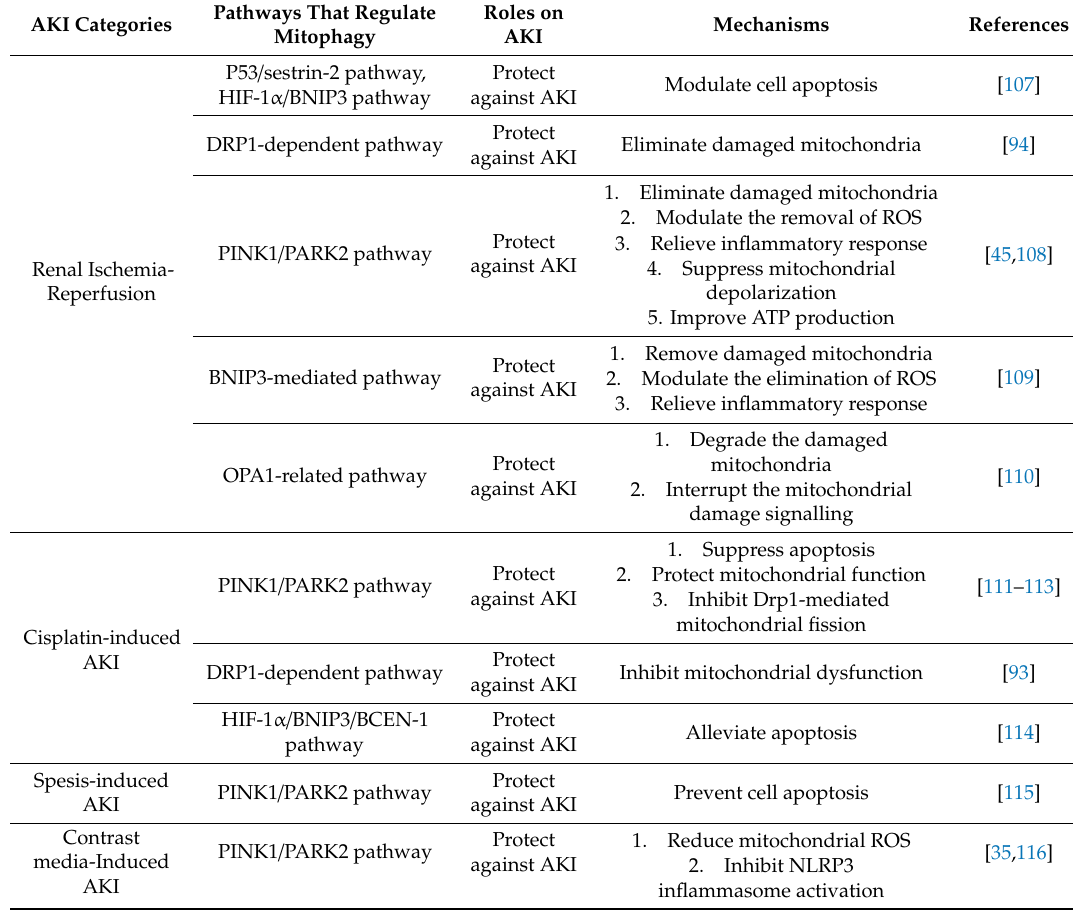
Table 1. Summary of the studies of mitophagy in acute kidney injury